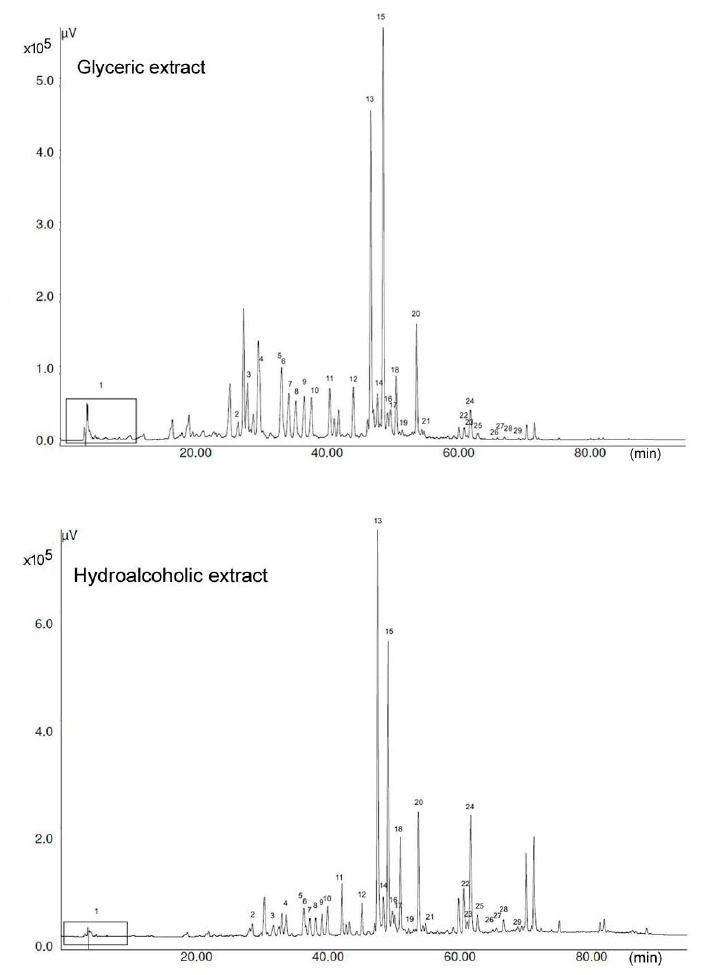
Figure 1. High-performance liquid chromatography-UV (HPLC-UV) profile of the various propolis preparations. Polyphenols species are numbered accordingly and listed in Table 1.